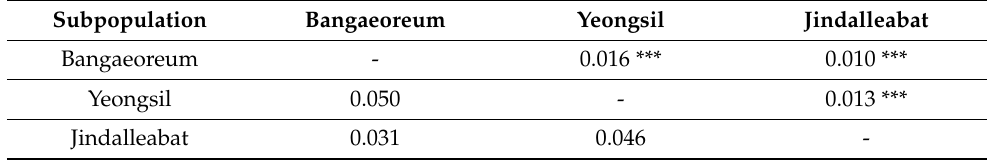
Table 5. Nei’s genetic distance below the diagonal and pairwise F ST values above the diagonal among the three subpopulations of Abies koreana